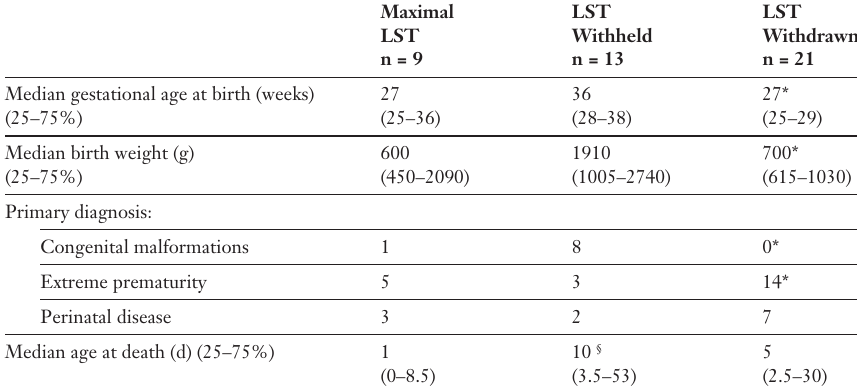
Epidemiological data of all deaths in the ICU from April 2001 to March 2004.